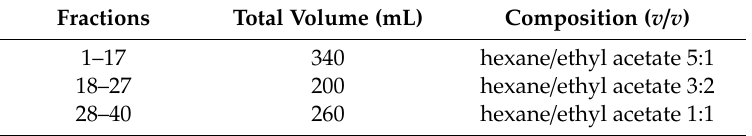
Table 2. Volume and composition of the fractions in the second fractioning of ginger extract.